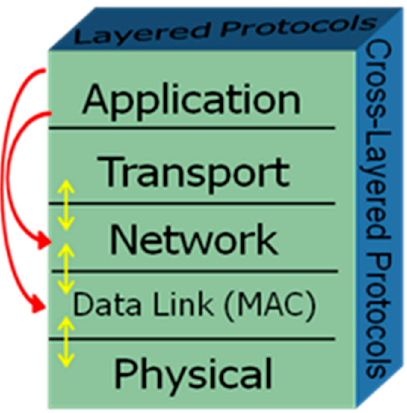
Figure 1. Cross-layer design. Yellow arrows refer to existing protocols discussed in the section; red ones to our approach that led to devising the proposed protocol.